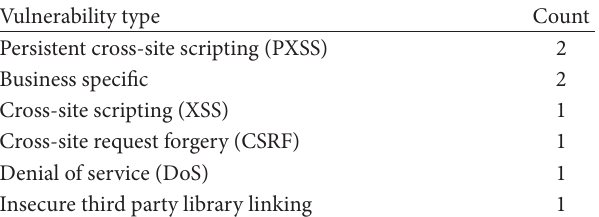
Table 2: VOMS vulnerability